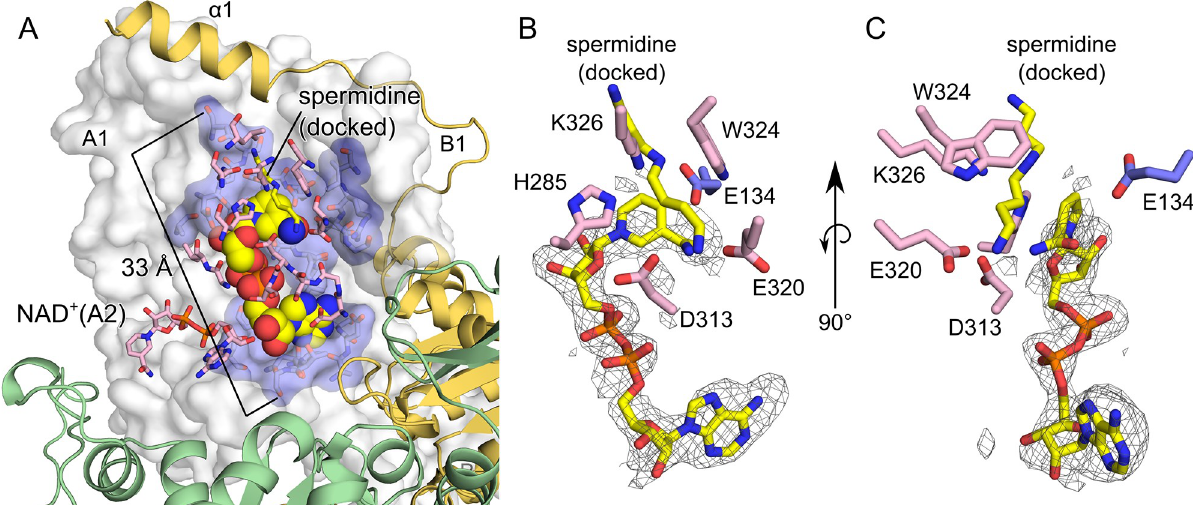
Fig 4. Details of the BmDHS active site. (A) Protomer A1 is shown as a white surface, with residues within a 4 Å radius of the NAD + cofactor (spheres) shown as blue sticks and highlighted by pale blue surface. Residues in protomer A2 within a 4 Å radius of the NAD + cofactor bound to protomer A1 are shown as pink sticks. The NAD + cofactor bound to protomer A2 is also shown as pink sticks. Protomers B1 (yellow) and B2 (green) are shown as cartoon. (B, C) Close view showing catalytically-important residues within BmDHS active site. Polder OMIT map [65] for NAD + . The grey mesh represents the ( mF obs - DF model ) OMIT difference density contoured at 3.0 σ . Spermidine (yellow stick) was docked following the superposition of the crystal structure of BmDHS onto the crystal structure of spermidine-bound HsDHS (PDB ID 6XXK) [44] using Pymol (Schro¨dinger,